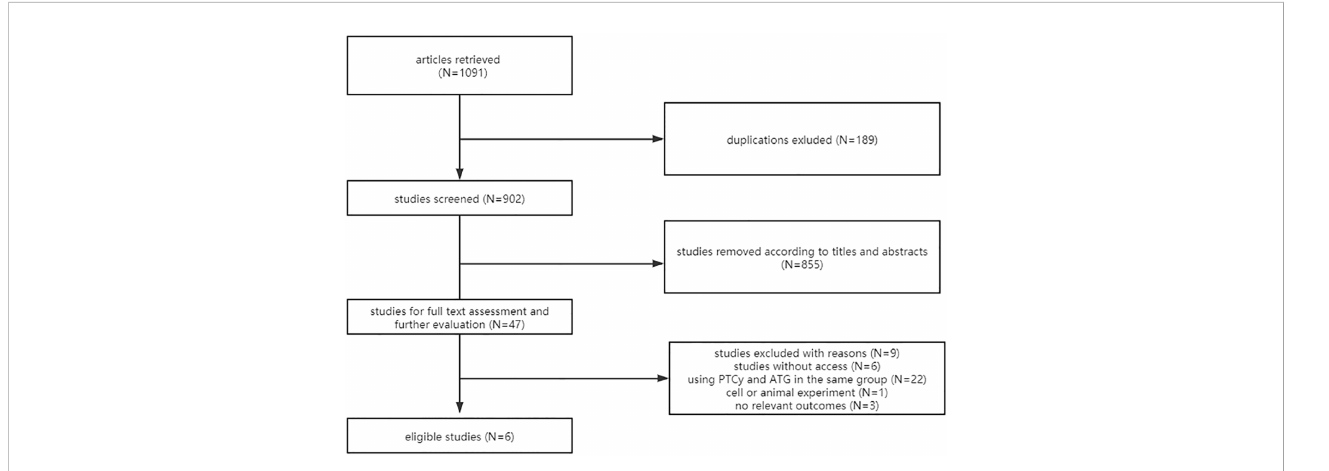
FIGURE 1 Flow diagram of study